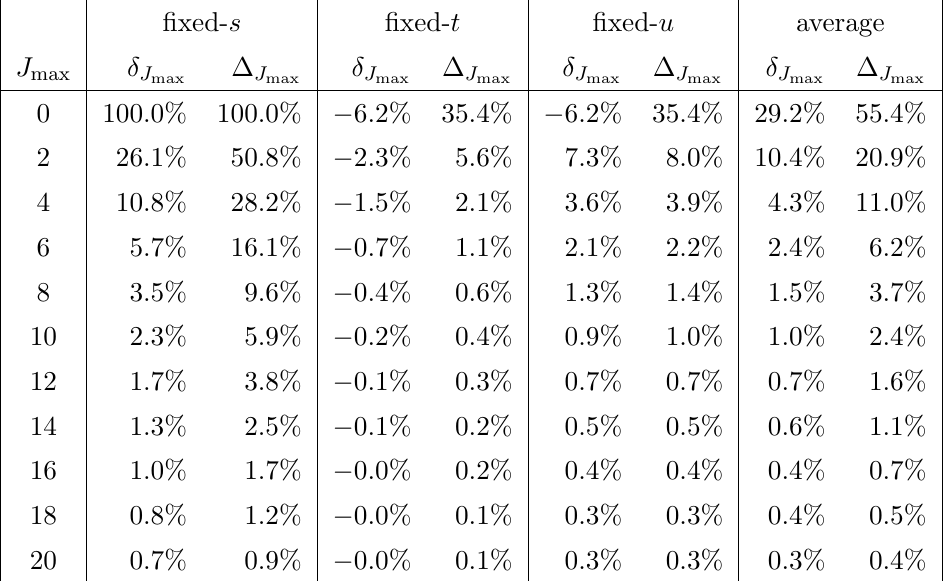
Table 2. Convergence of the partial-wave expansion in the case of the pion box: the three single- variable dispersion relations and their average are compared. See main text for the de(cid:12)nition of the relative